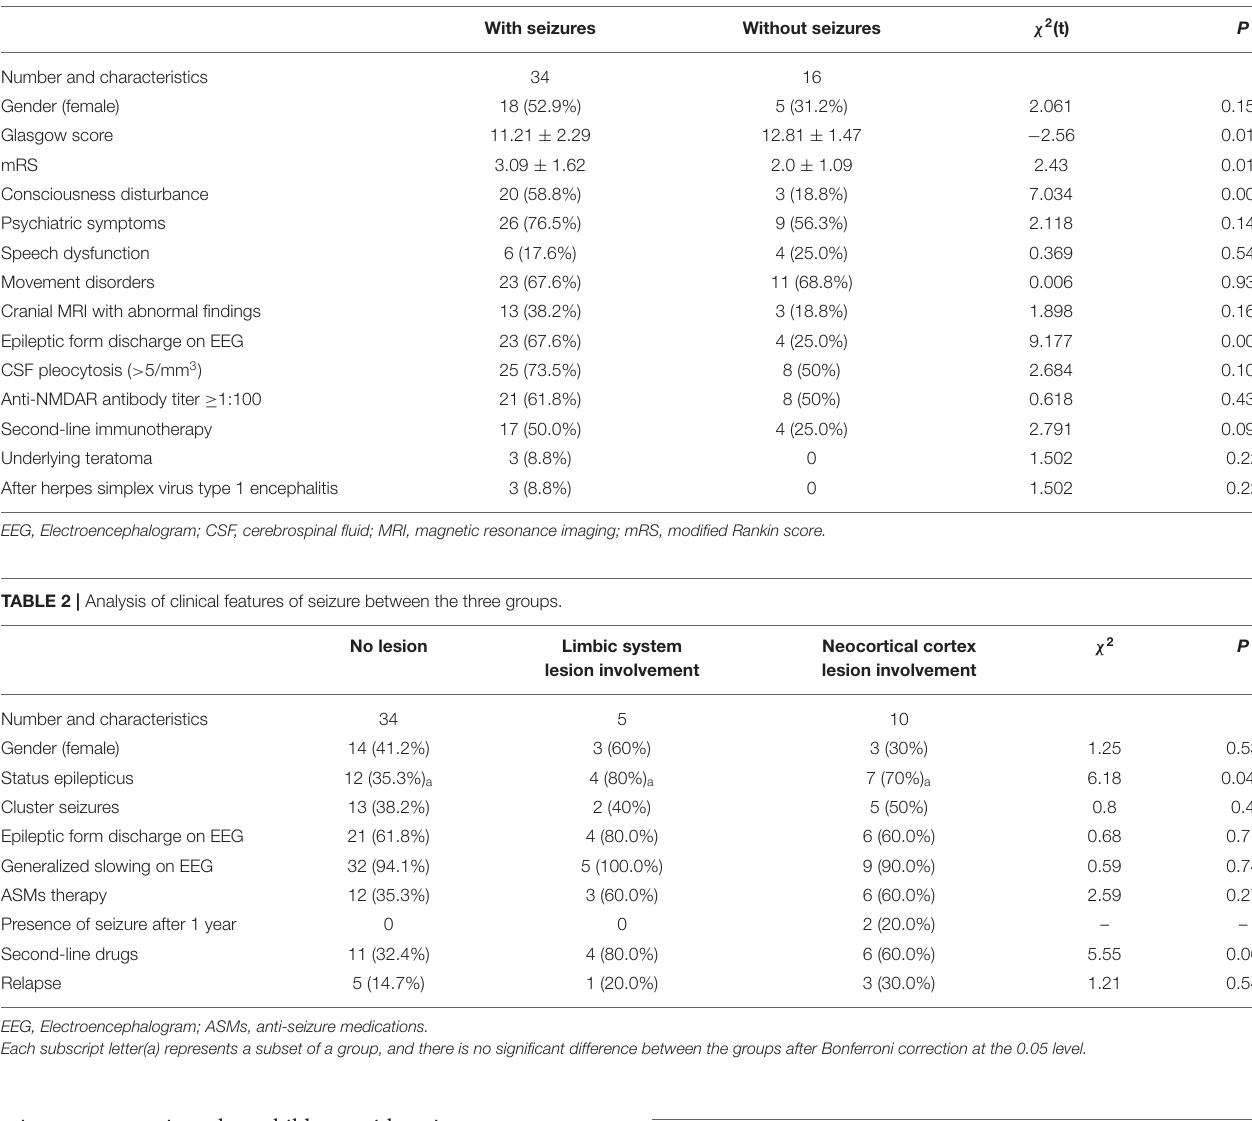
TABLE 1 | Comparison of clinical characteristics between patients with or without seizures. With seizures Without seizures χ 2 (t) P